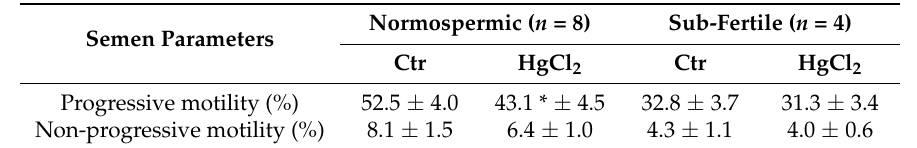
Table 3. Effect of mercury chloride (HgCl 2 ) on progressive and non-progressive motility of normospermic and sub-fertile subjects.